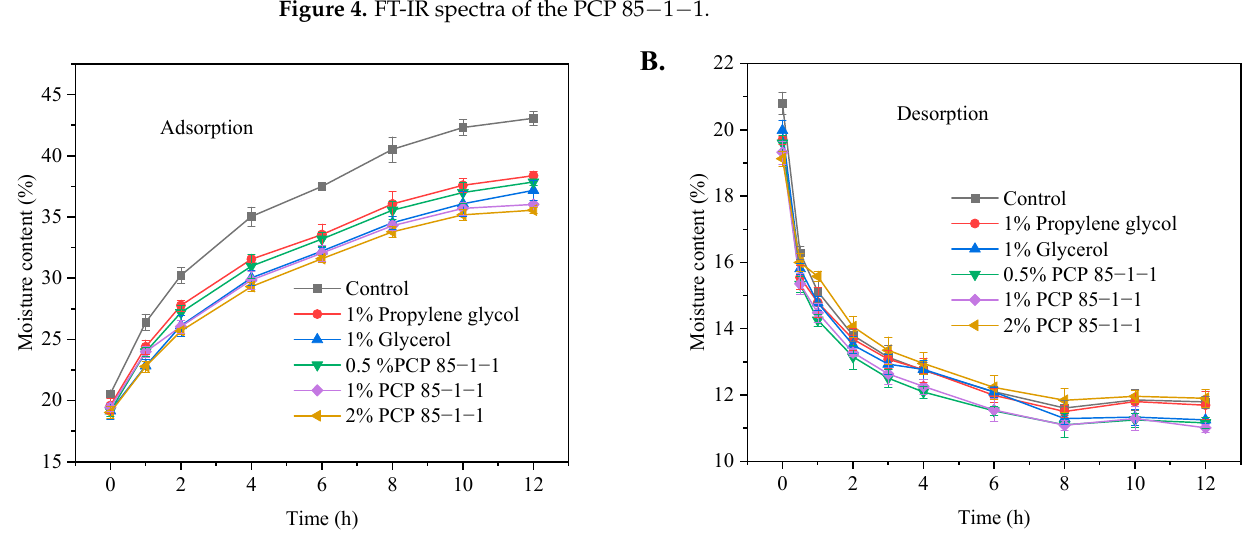
Figure 5. ( A ) Moisture adsorption of tobacco shreds with PCP 85 − 1 − 1. ( B ) Moisture desorption characteristics of tobacco shreds with PCP 85 − 1 − 1.